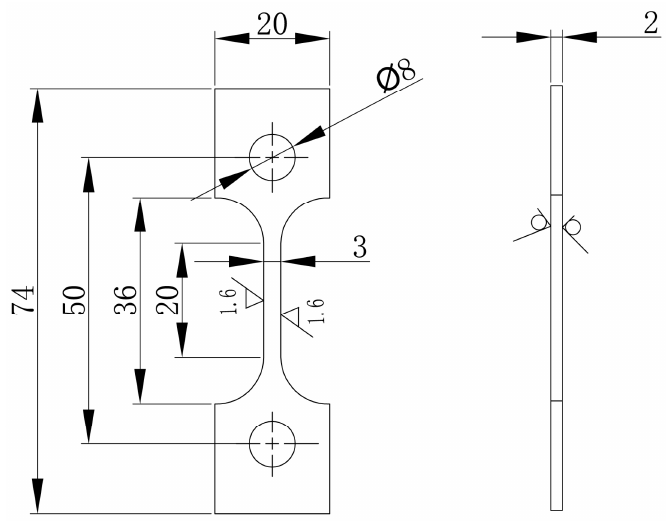
Figure 3. Details of the corrosion fatigue specimen (unit: mm).